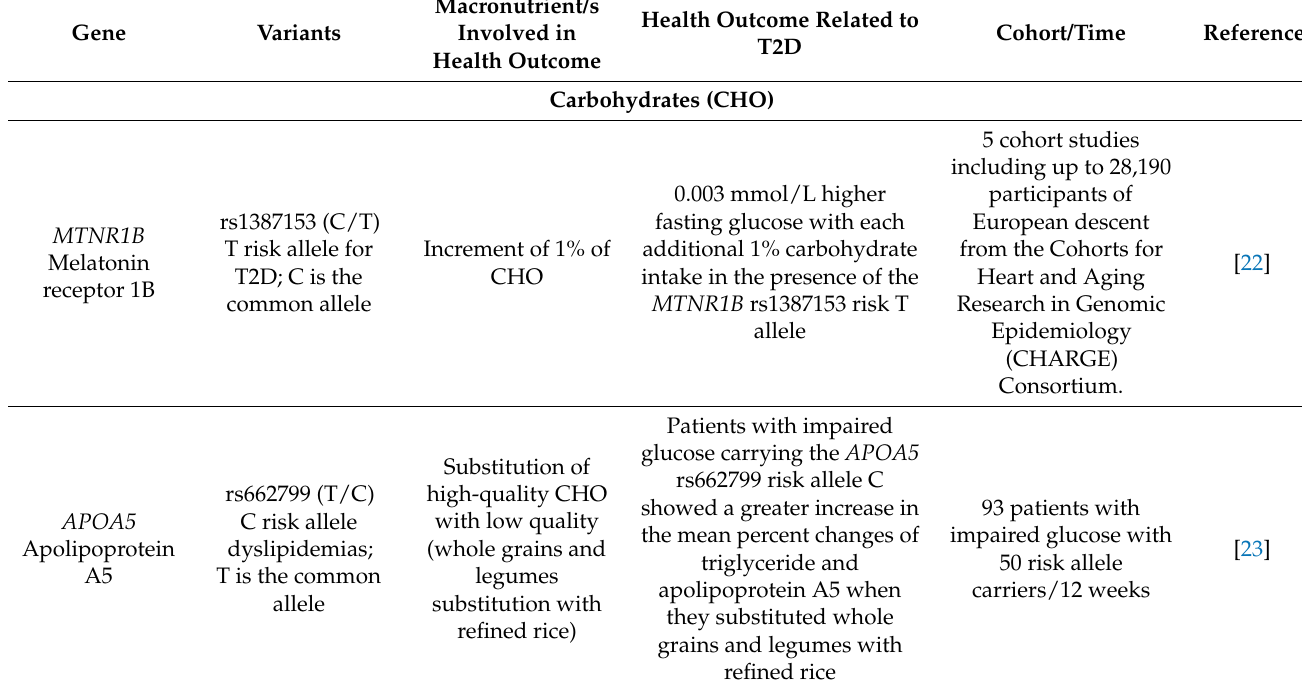
Table 1. Gene variants associated with the selection of specific macronutrients for the dietary management of T2DM. Gene Variants